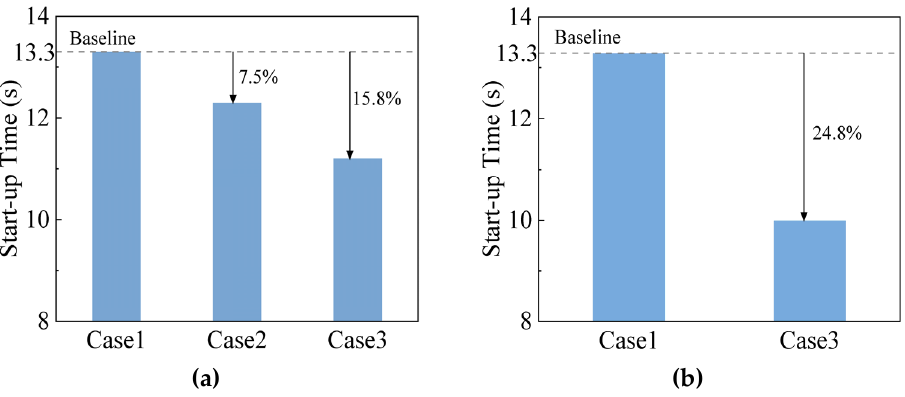
Figure 7. Start-up time for variable EBP at different cases. ( a ) EBP = 10 kPa; ( b ) EBP = 25 kPa.